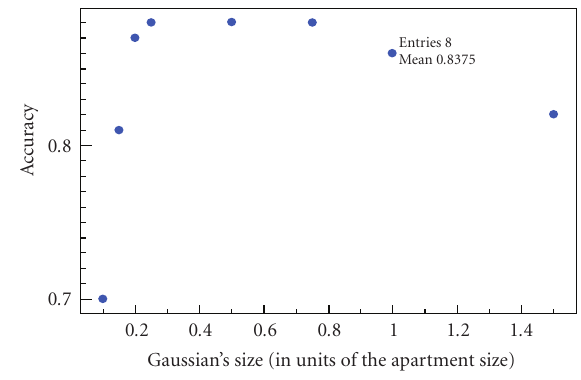
Figure 7: Variation of the system’s accuracy with the dynamics, in presence of 2.5% noise.